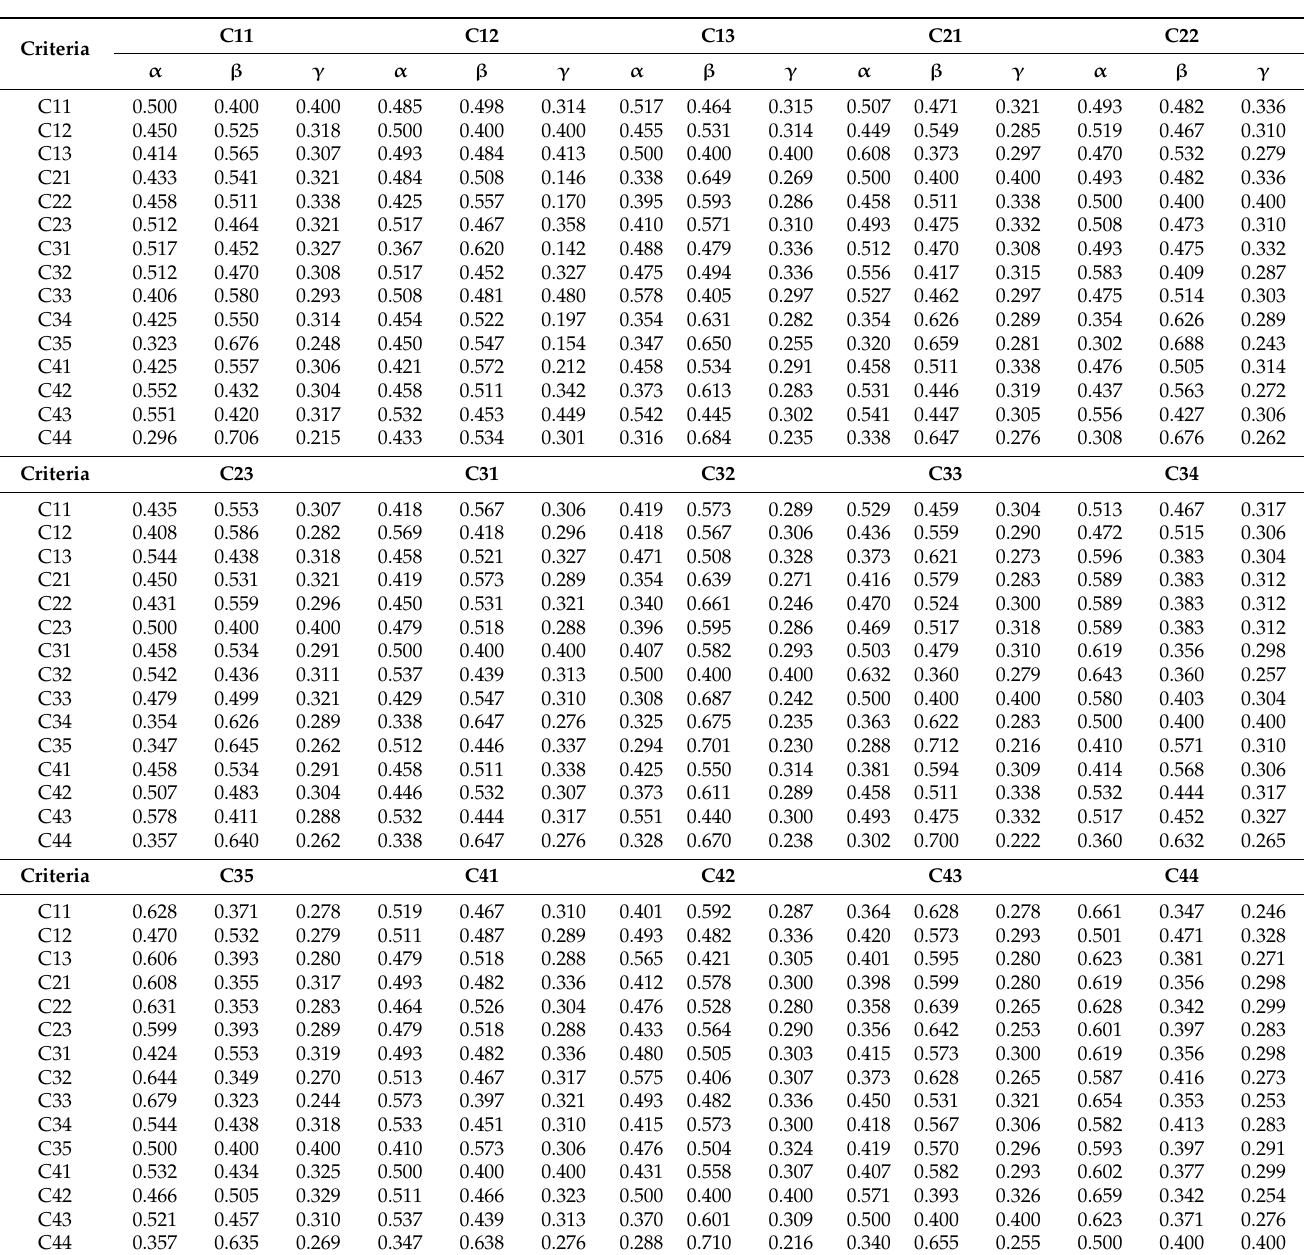
Table A1. The integrated spherical fuzzy comparison matrix of